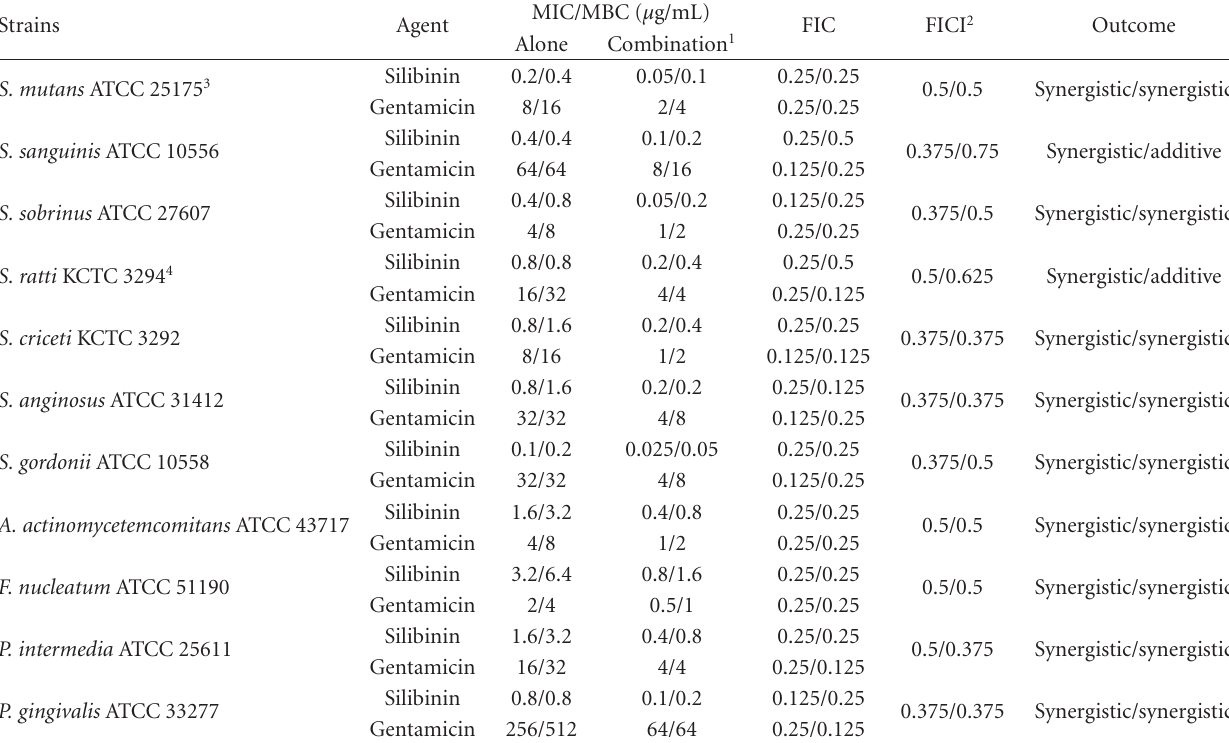
Table 3: Synergistic e ff ects of the silibinin with gentamicin against oral bacteria.